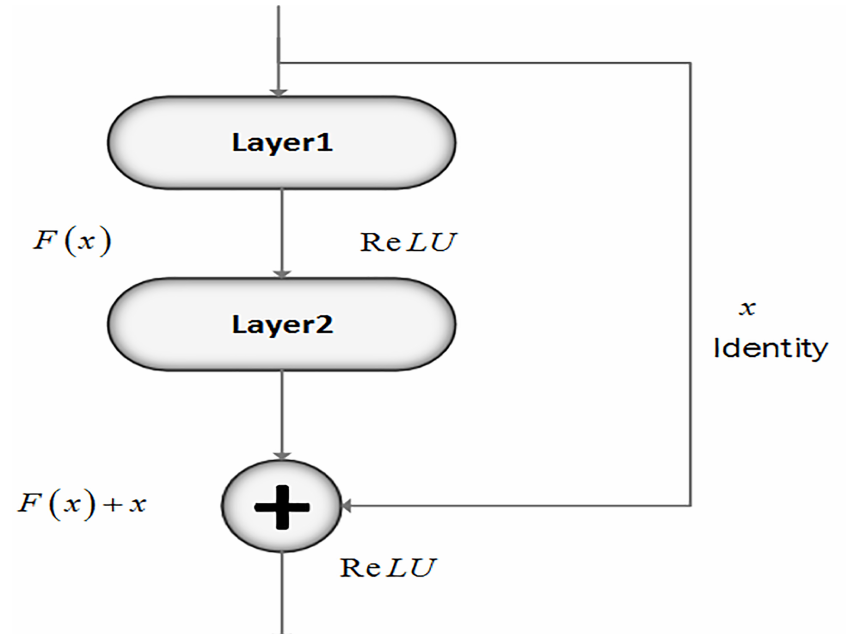
Figure 4. ResNet residual block.